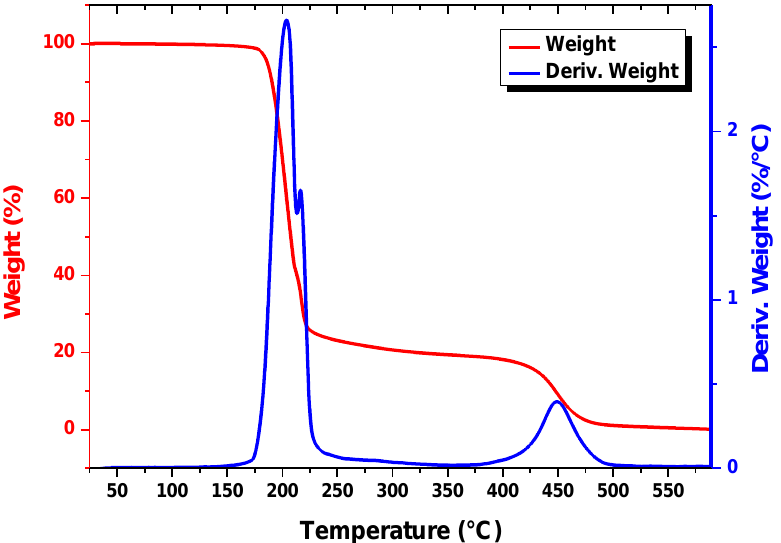
Figure 3. Weight loss of thiourea versus temperature and gCN formation.